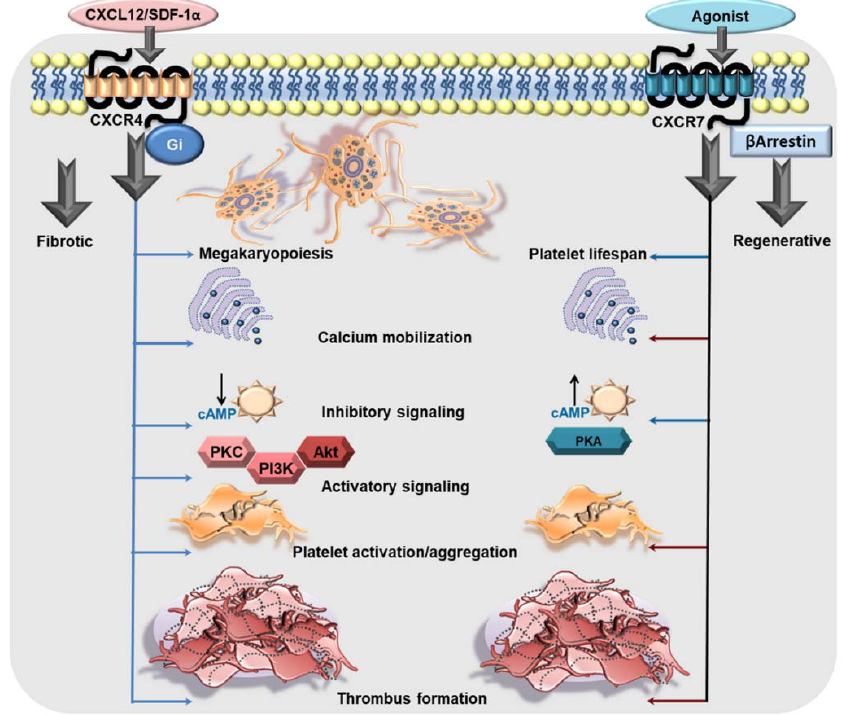
Figure 1. The functional dichotomy of CXCR4 and ACKR3/CXCR7 in platelets. CXCR4 is a G α i ‐ coupled GPCR which may exert its influence on platelet biogenesis (megakaryopoiesis), and a pro ‐ thrombotic response. CXCL12/SDF1 α engages CXCR4 on platelets to trigger intraplatelet ‐ calcium mobilization, the platelet activatory signaling pathway involving PI3K, Akt, which promotes platelet activation, aggregation, and a pro ‐ thrombotic response. Moreover, G α i ‐ coupled CXCR4 induces a canonical signaling cascade following ligation by CXCL12/SDF ‐ 1 α that imposes an inhibitory effect on AC and impedes the generation of cAMP. On the contrary, ACKR3/CXCR7 is an atypical GPCR which does not engage a G protein but mostly β‐ arrestin. Physiological and pharmacological ligands of ACKR3/CXCR7 promote platelet survival. ACKR3/CXCR7 ‐ ligation by a pharmacological agonist (VUF11207) counteracts calcium mobilization induced by platelet ‐ activating stimuli. ACKR3/CXCR7 ‐ ligation triggers the platelet inhibitory signaling cascade involving AC ‐ cAMP ‐ PKA, while counteracting activatory signaling mediators to impose an inhibition on platelet activation, degranulation, aggregation and pro ‐ thrombotic response (red arrows denote an inhibitory effect on the process). This exemplifies the functional dichotomy of platelet CXCR4 and ACKR3/CXCR7 in mediating pro ‐ and anti ‐ thrombotic effects respectively.